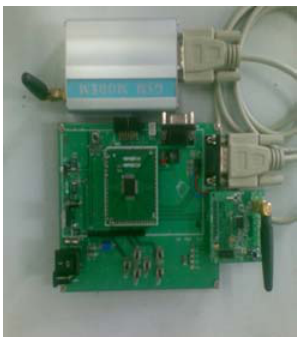
Figure 22. Actual data base